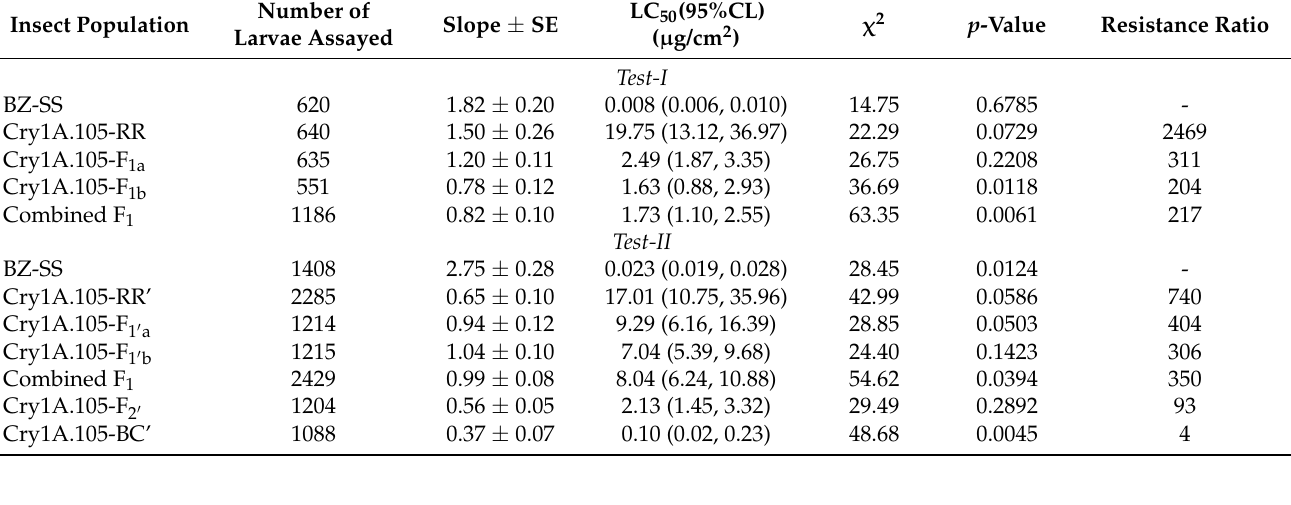
Table 2. Concentration-responses of different genetic populations of H. zea to Cry1A.105 in diet overlay bioassays.